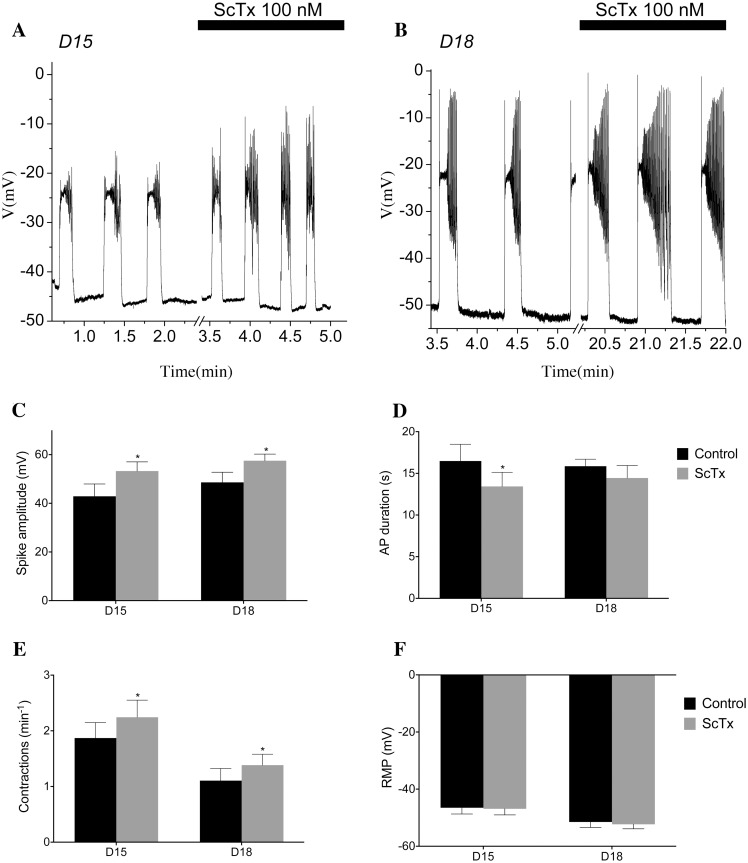
ScTx modulates AP frequency, duration, and spike amplitude.Spontaneous electrical activity recorded from the longitudinal layer of D15 & D18 murine myometrium (A, B). Activity consisted of slow depolarisation to threshold, followed by an action potential composed of a plateau upon which a number of spikes were superimposed. The bar represents the maximum effect in the presence of 100 nM ScTx. (C) Mean AP spike amplitude increase from 42.87±5.07 mV to 53.25±3.78 mV (p ≤ 0.05) in D15 tissue (n = 6) and from 45.5±4.96 mV to 56.21±3.37 mV in D18 tissue (n = 6). (D) Decrease in mean AP duration from 16.77±2.14 s to 11.87±0.76 s (p ≤ 0.05) in D15 tissue but no significant difference in D18 tissue. (E) Application of 100 nM of ScTx increased AP frequency in the D15 samples from a mean of 1.69±0.18 to 2.31±0.34 AP min−1 and from 1.11±0.22 to 1.38±0.19 AP min−1 in D18 tissue. (F) ScTx did not alter the resting membrane potential of either D15 or D18 (p ≤ 0.01).